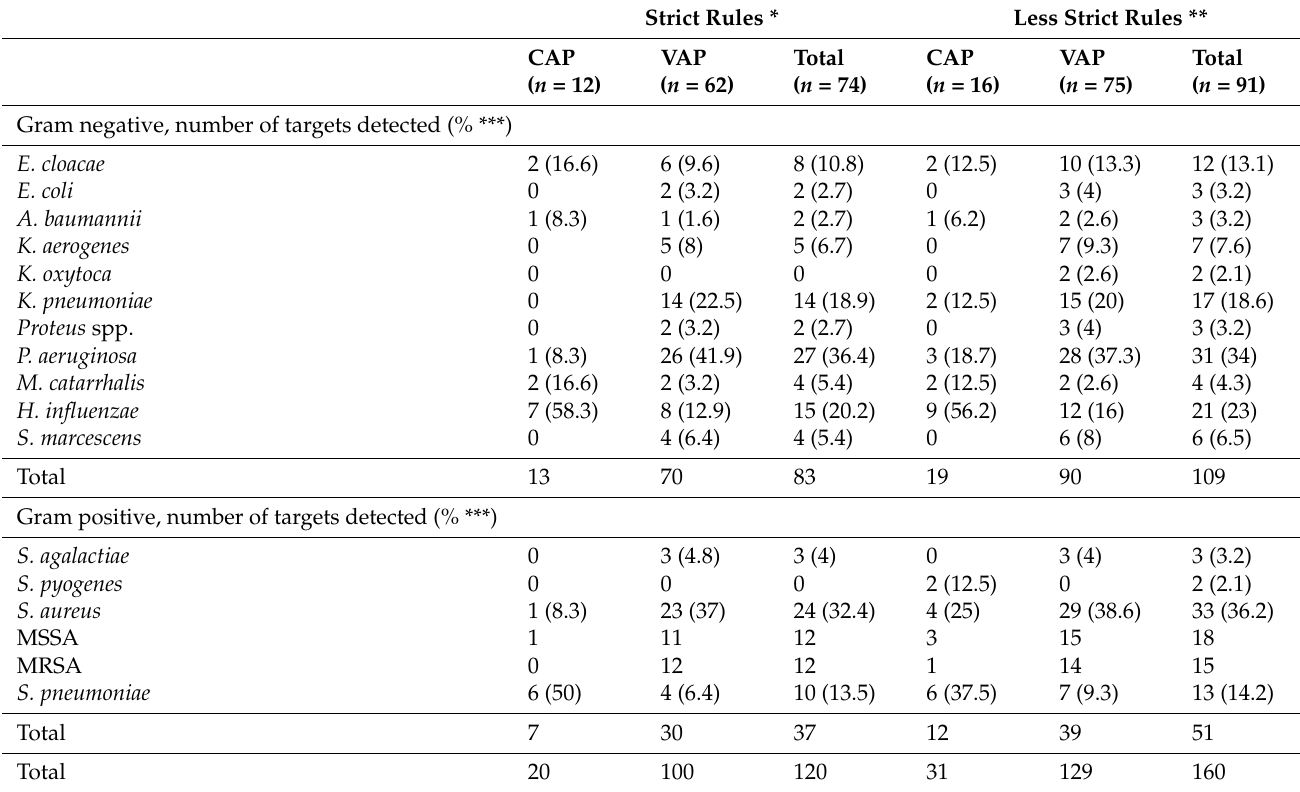
Table 3. Bacteria identified by FA tests using two sets of rules among patients with CAP and